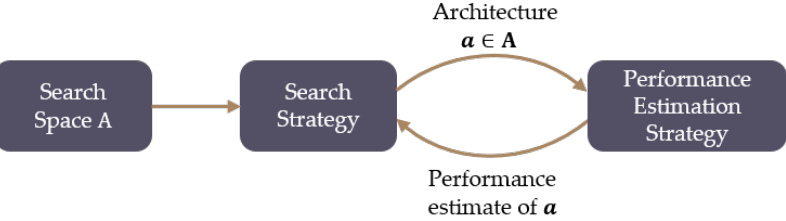
Figure 7. Flow path of neural architecture search technology.